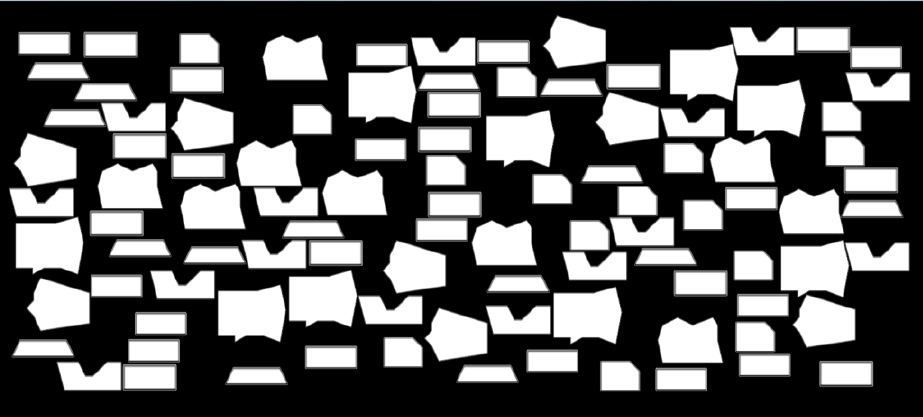
Figure 15. Solution found by the ILS algorithm inserting 101 pieces for the Shirts instance, con- suming 2 h of processing time.